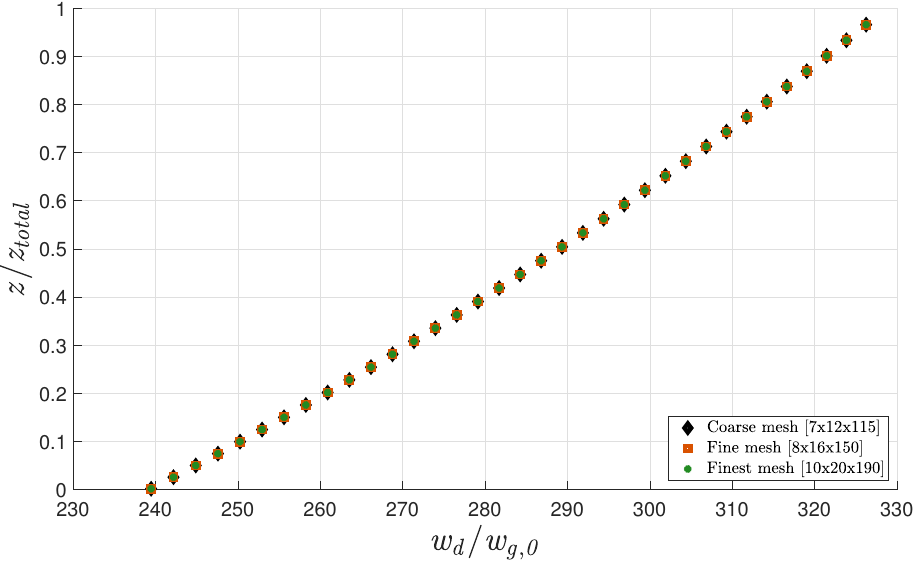
Figure 2. Grid independence study for three distinct